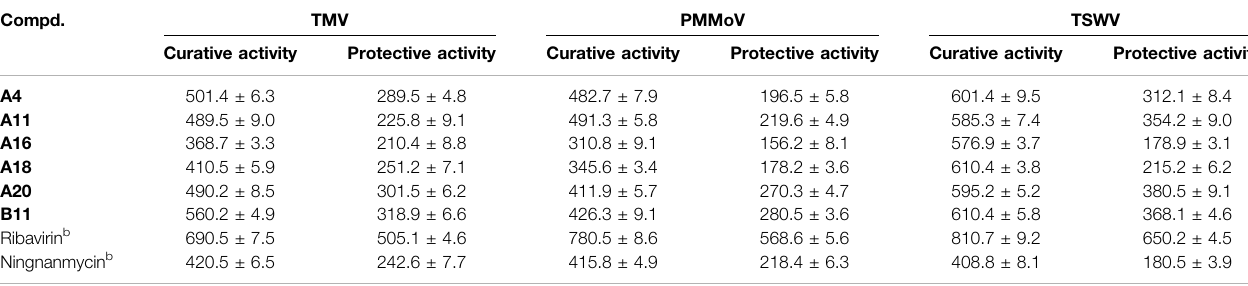
TABLE 5 | The EC 50 values of the compounds against TMV, PMMoV, and TSWV a .